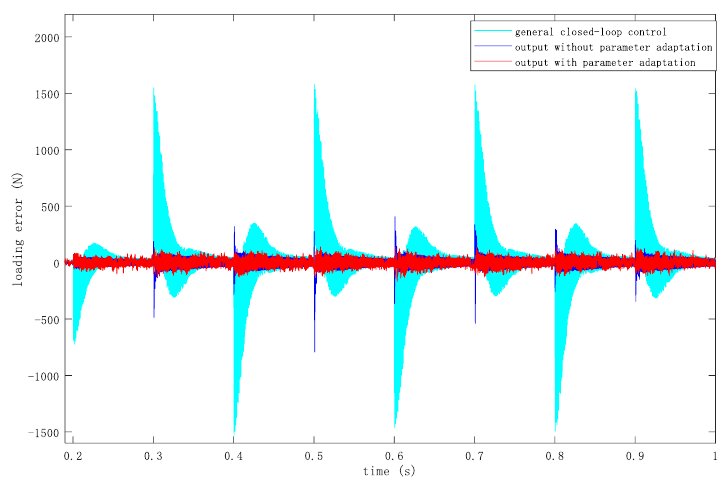
Figure 16. Loading error comparison under different control methods. Table 3. System loading error comparison.